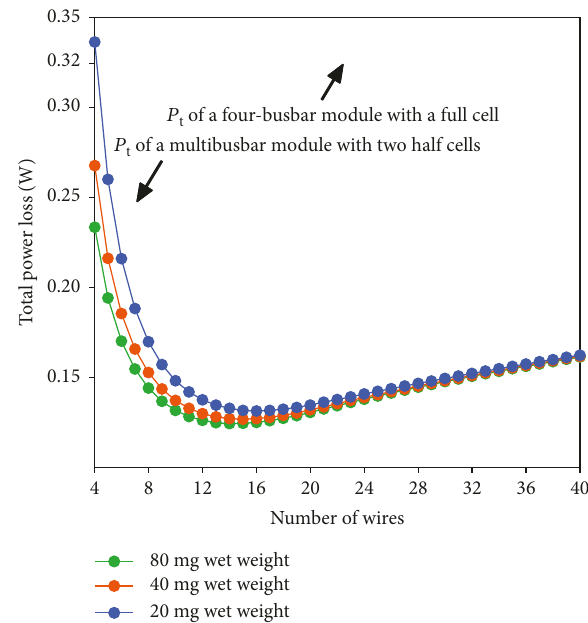
Figure 13: The P t of three MBBHC modules and a conventional module: (1) multibusbar modules with two half cells, respectively, the wire numbers range from 4 to 40, and the fi nger wet weights are 80 mg, 40mg, and 20mg; (2) a four-busbar module with a full cell, whose fi nger wet weight is